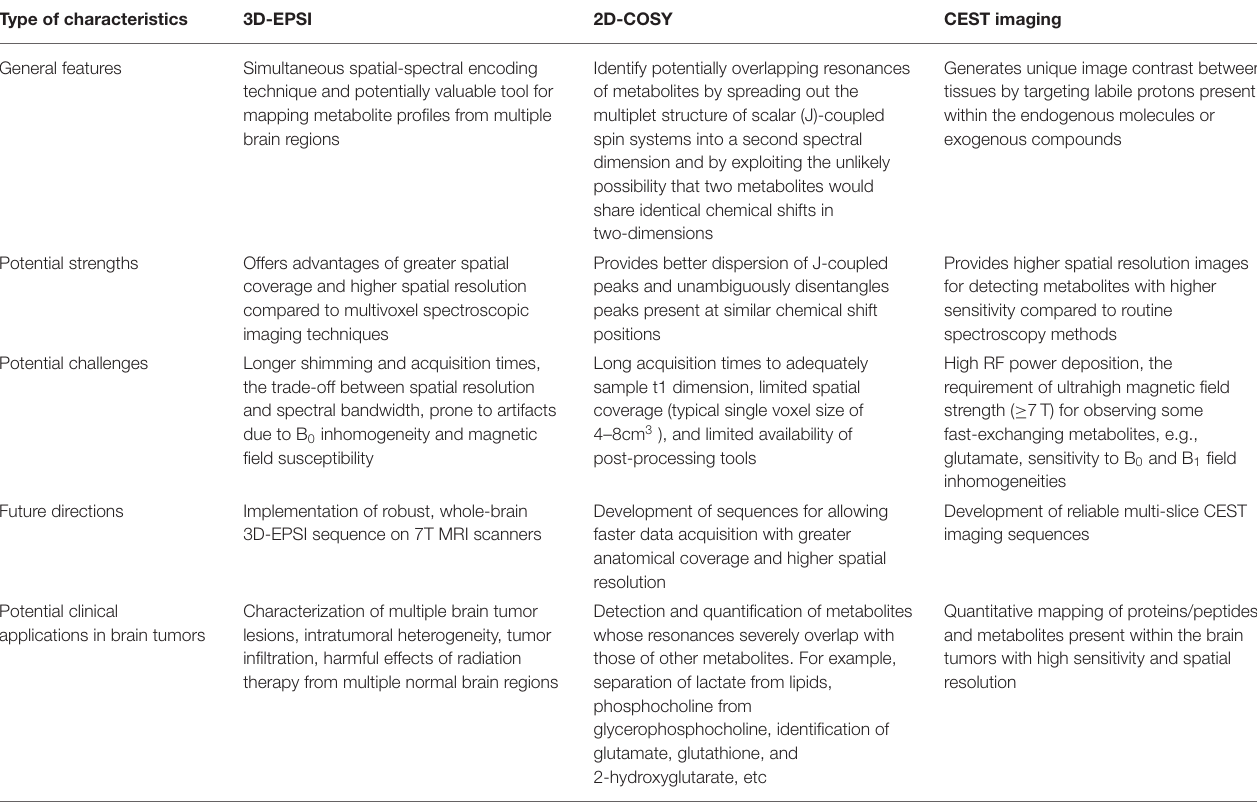
TABLE 1 | Head-to-head comparison of three metabolic techniques (3D-EPSI, 2D-COSY, and CEST imaging). Type of